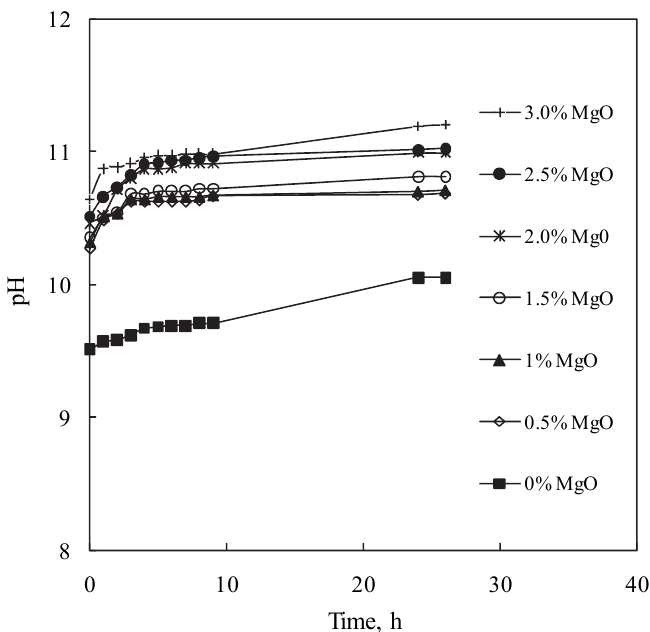
Fig. 1 Variation of pH with time for Na-Bentonite + MgO suspensions at different MgO additions.